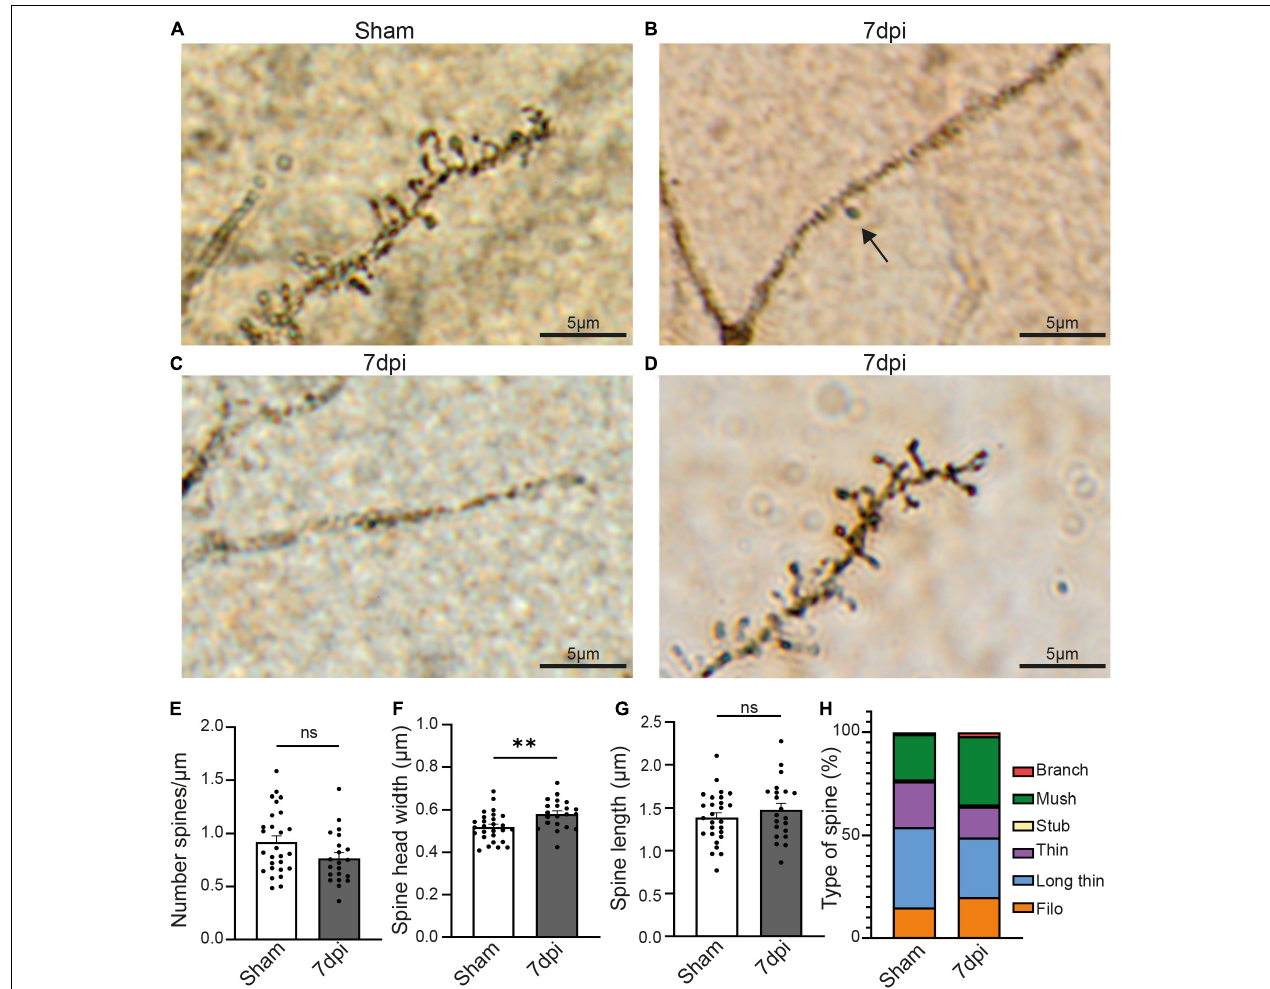
FIGURE 4 | mTBI induces changes in pyramidal neurons’ synaptic spines. (A) Representative Golgi staining of synaptic spines in the pyramidal cell of a sham animal. (B) Representative Golgi staining of a dendrite of a pyramidal cell where only one spine can be visualized (black arrow) 7 dpi animal. (C) Representative Golgi staining of a pyramidal cell in a 7 dpi animal, in which dendritic spines cannot be visualized. (D) Golgi staining of dendritic spines of a pyramidal cell in which dendritic spines are visible 7 dpi. (E) Spine density (number of spine/ µ m) in dendrites where spines were visible. Each dot represents a cell (Sham: 0.9207 ± 0.05819, n = 27 cells, 3 animals; 7 dpi: 0.7677 ± 0.05374, n = 21 cells, 3 animals). Two-tailed t -test: non-significant, p -value = 0.0660. (F) Spine head width ( µ m) in dendrites where spines were visible. Each dot represents a cell (Sham: 0.5194 ± 0.01329, n = 27 cells, 3 animals; 7 dpi: 0.5811 ± 0.06883, n = 21 cells, 3 animals). Two-tailed t -test: significant, p -value = 0.0035 (** p -value ≤ 0.01). (G) Spine length ( µ m) in dendrites where spines were visible. Each dot represents a cell (Sham: 1.388 ± 0.05715, n = 27 cells, 3 animals; 7 dpi: 1.480 ± 0.07562, n = 21 cells, 3 animals). Two-tailed t -test: non-significant, p -value = 0.3310. (H) Descriptive graphic with the percentage of each spine type (red: branch, green: mush, yellow: stub, purple: thin, blue: long thin, orange: filo) in sham and 7 dpi animals.